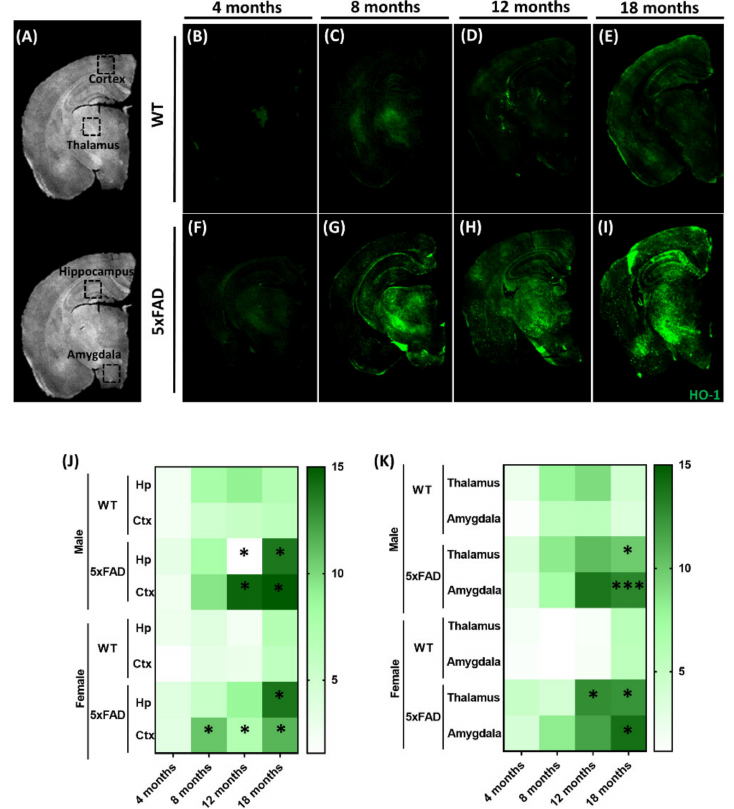
Figure 1. Brain HO-1 expression increases with aging and, preferentially, in 5xFAD mice. ( A ) Whole brain representative images showing the brain regions studied. Representative 10x whole brain images of HO-1 (green) in WT and 5xFAD animals at di ff erent time points: 4 months ( B , F ), 8 months ( C , G ), 12 months ( D , H ) and 18 months ( E , I ) of age, respectively. Heat maps representing HO-1 mean expression in hippocampus and cortex (J ) and thalamus and amygdala ( K ) both in male and female WT and 5xFAD mice. Data represent mean ± S.E.M. ( N = 3–4). Significant di ff erences were considered when: * p < 0.03 and *** p < 0.001 compared to age-matched WT